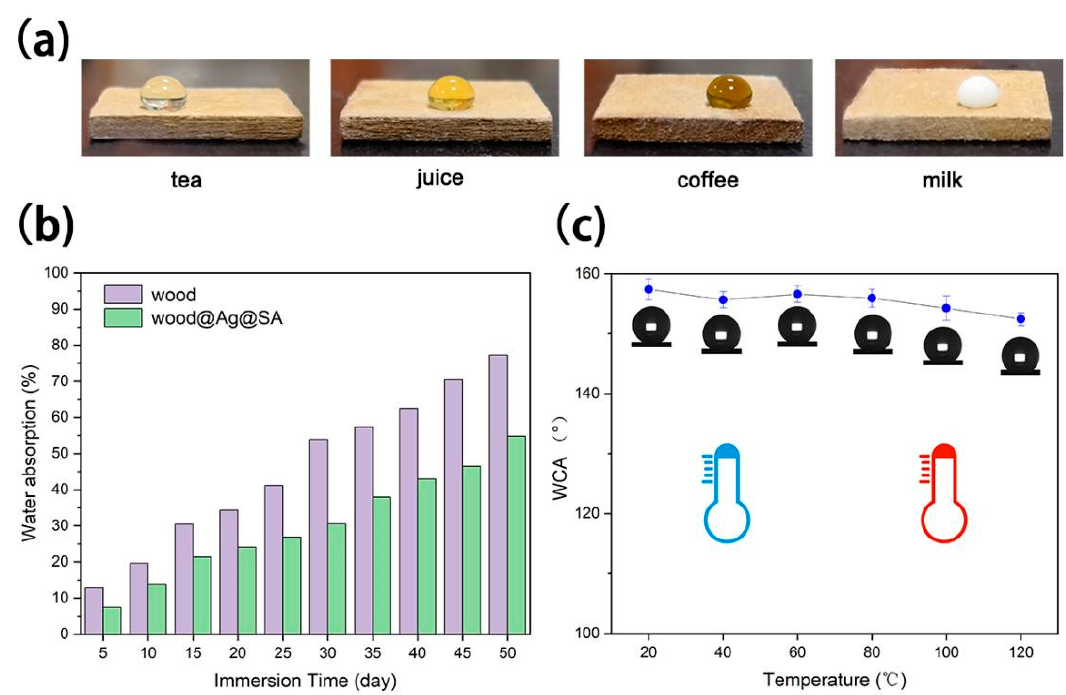
Figure 7. The images of different contaminants on the wood@Ag@SA ( a ) Changes of water adsorption for wood@Ag@SA as a function of time after immersion in water; ( b ) changes of WCA for wood@Ag@SA as a function of time after being treated in a constant temperature blast drying oven at the temperature of 20 ◦ C, 40 ◦ C, 60 ◦ C, 80 ◦ C, 80 ◦ C, and 120 ◦ C for six hours ( c